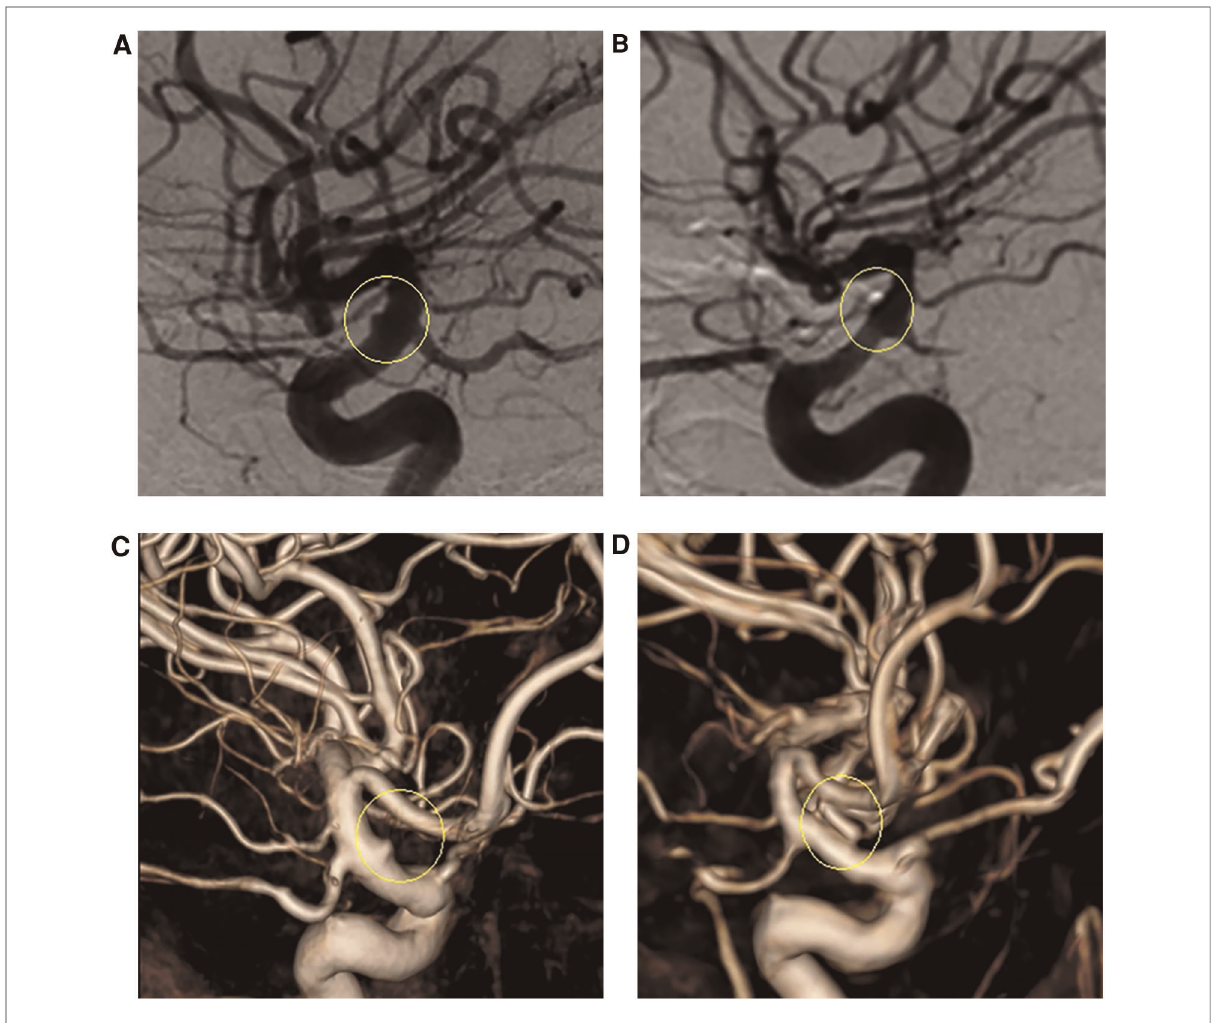
FIGURE 4 ( A,C ) Presurgical two-dimensional and three-dimensional digital subtraction angiography (DSA) images, respectively. ( B,D ) DSA images 1 year after surgery revealing that the aneurysm had not recurred, and the parent artery was well